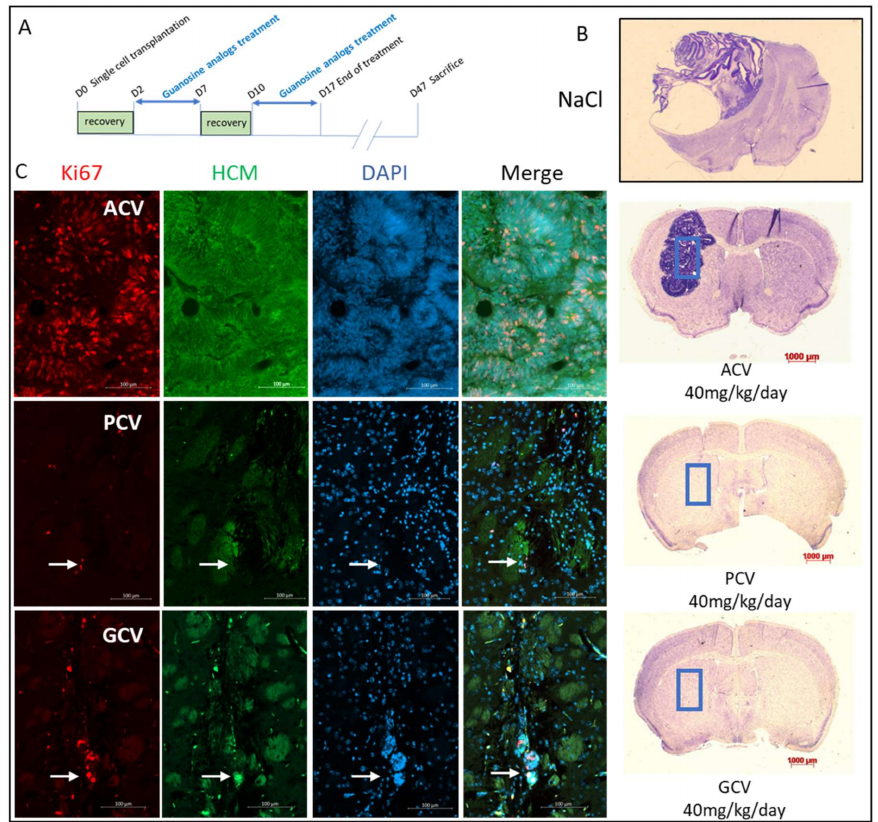
Figure 7. in vivo validation of suicide gene and inducers. ( A ) Schematic diagram of the experimental setup to detect tumor elimination in vivo. NOD/SCID mice were transplanted with 20,000 SR39h- expressing hESC through stereotactic injection into the striatum. 48 h post transplantation, mice were intraperitoneally injected with the respective nucleoside (40 mg/kg) for five consecutive days a week during a two-week period. Control mice were treated with a NaCl solution. Mice were sacrificed 47 days post transplantation. ( B ) Cresyl violet staining of a brain section. Tumor formation is clearly visible in control and ACV-treated mice (right hemisphere, where human hESC had been injected). ( C ) Immunostaining of brain coronal section (sections from ACV-, PCV-, and GCV-treated mice are shown in the upper, middle, and lower row, respectively). Staining with the proliferation marker Ki67 and with the human cytoplasmic marker (HCM) are shown in red and green, respectively. Nuclei were counterstained with DAPI (blue). White arrows show residual proliferative cells form the graft. A merge of the three staining is shown in the right column. Each experimental group consisted of five